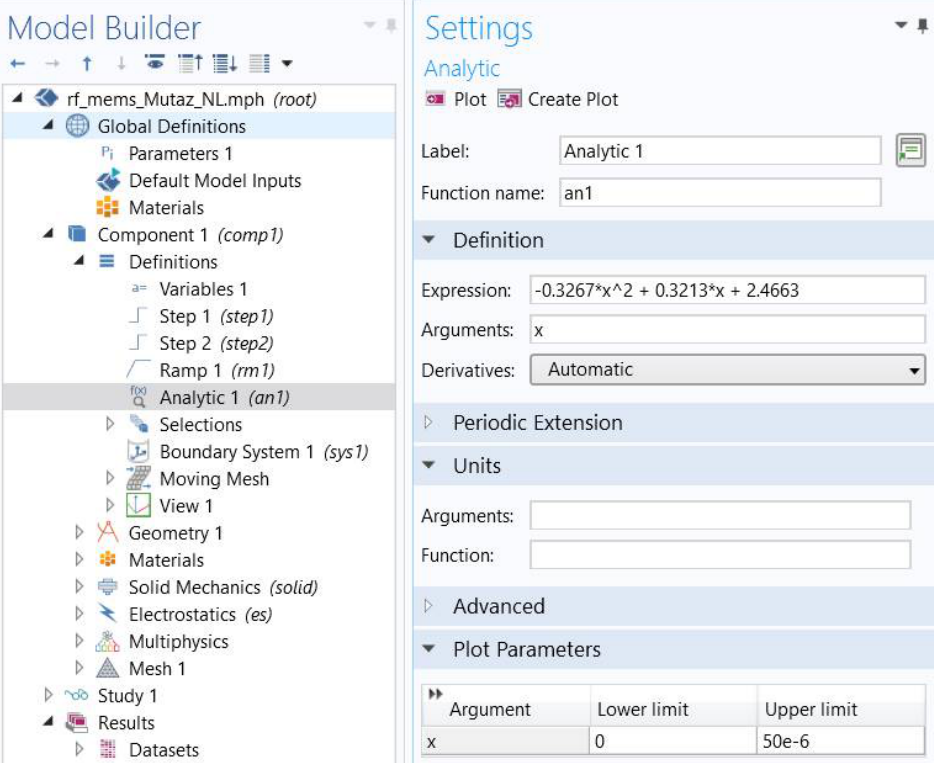
Figure 14. Model configuration and setting on COMSOL.